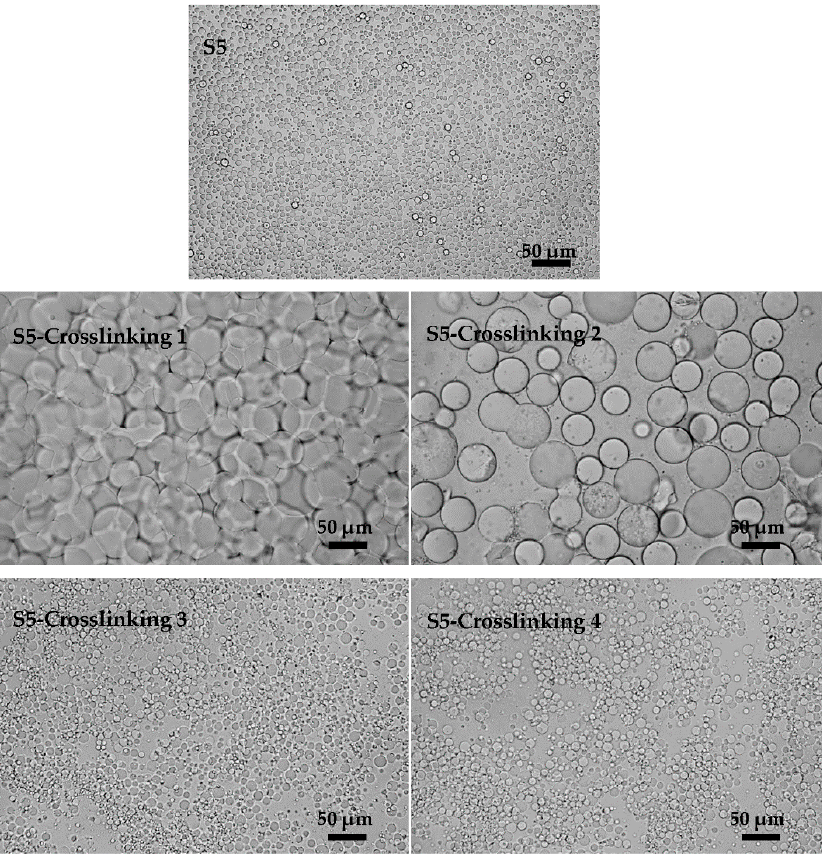
Figure 12. Microscopic photographs of KGM microspheres prepared by different feeding modes of EC: S5 was KGM emulsions before crosslinking and S5-Crosslinking 1 (EC was added slowly at 60 °C), S5-Crosslinking 2 (emulsions were stirred at 60 °C for 1 h and then EC was added), S5-Crosslinking 3 (EC solution (20 wt %, EC was mixed with oil phase adequately) was added in one batch at 60 °C) and S5-Crosslinking 4 (EC was added at 40 °C and then the temperature was increased to 60 °C) were the crosslinking results of S5 .